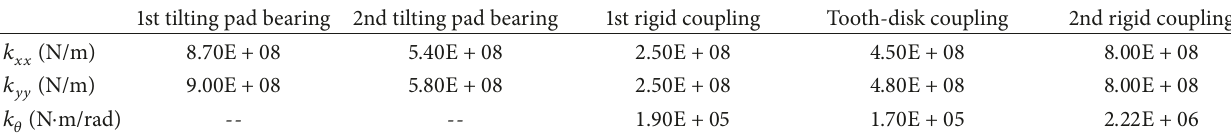
Table 2: Stiffness parameters of the external rotor